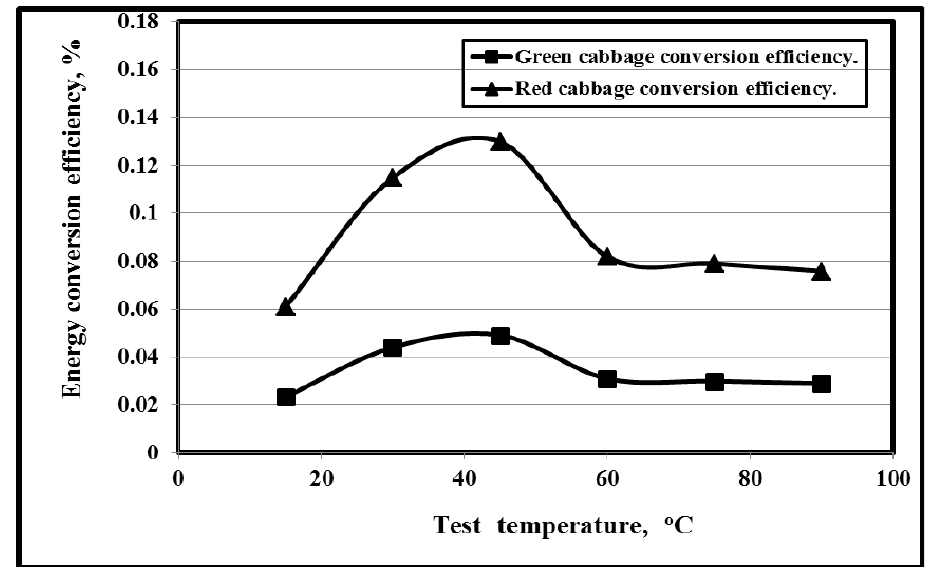
Figure 15. Conversion η /temp. relation for RC and GC.